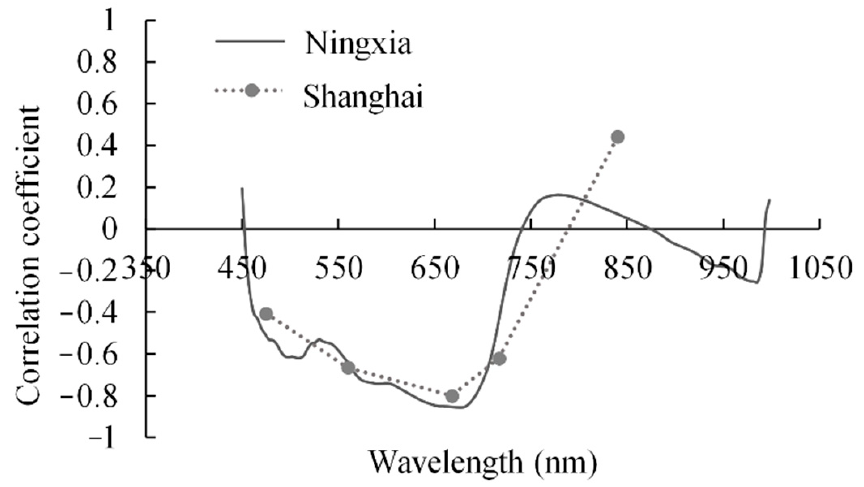
Figure 2. Correlation coefficients between the spectral reflectance and rice LCC in Ningxia and Shanghai.